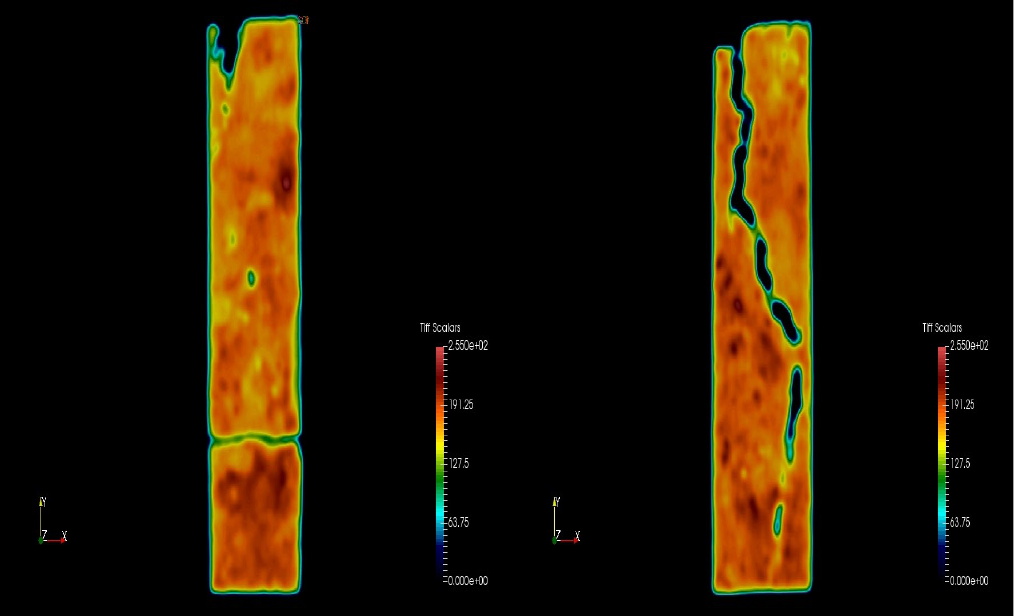
Figure 21. Comparison between applications of acid brine and SBs with EK.